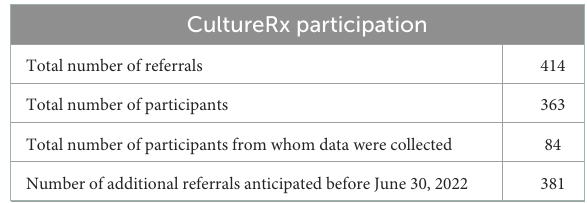
TABLE 4 Culture Rx participation